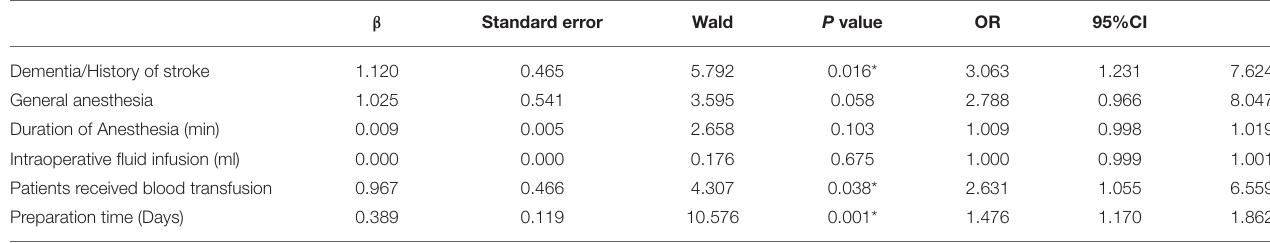
TABLE 2 | Multivariate analysis of Postoperative Delirium Preparation time was defined as the calendar days between the diagnosis of hip fracture and surgery.